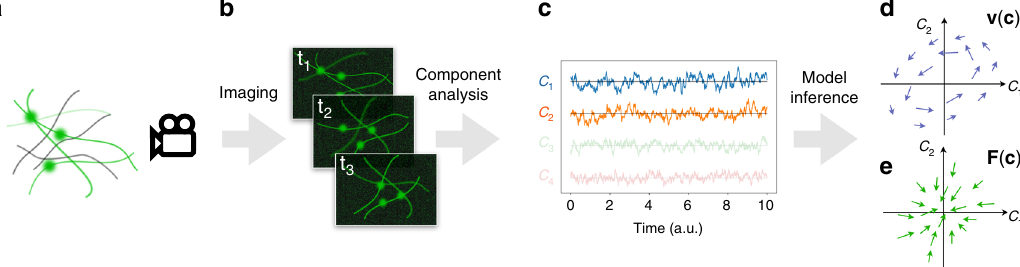
Fig. 1 Schematic illustration of our approach to learn non-equilibrium dynamics from a Brownian movie. a Sketch of a network of biopolymers (black) with embedded fl uorescent fi laments and beads (green). b Image-frames of the fl uorescent components in panel a at three successive timepoints. c The time trajectories of the projection coef fi cients c 1 ( t ), c 2 ( t ), ⋯ : the coef fi cients and respective trajectories discarded by the dimensional reduction are faded. Sketch of the inferred velocity v ð c Þ ( d ) and of the force fi eld F ð c Þ ( e ) in the space { c 1 , c 2